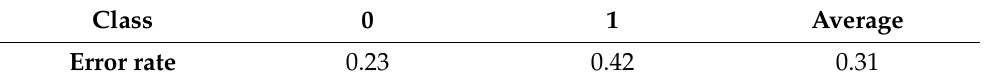
Table 8. Error rates for X. fastidiosa subsp. pauca severity classes using the non-parametric method.